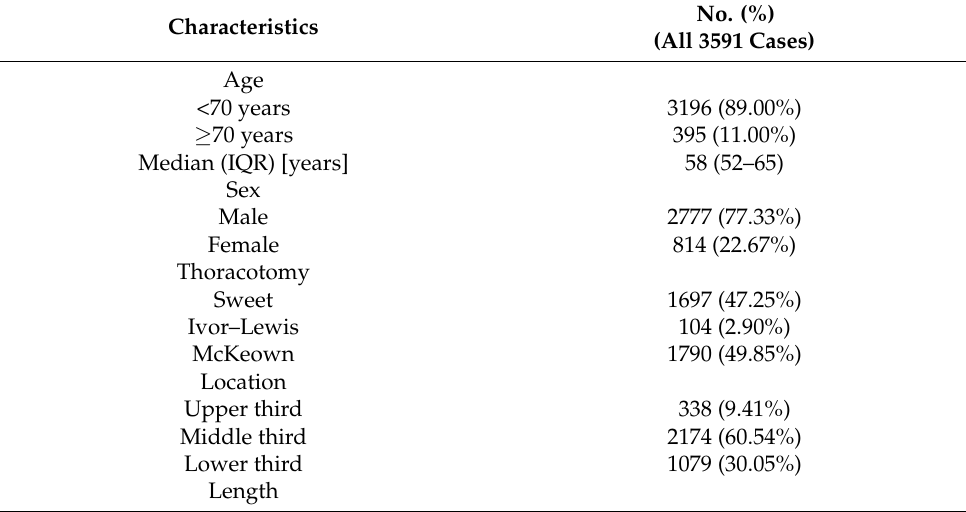
Table 1. Baseline clinicopathological characteristics of the included